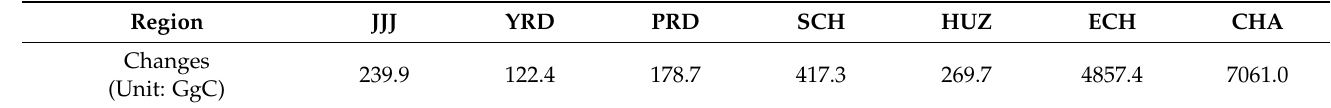
Table 5. Impact of land-use changes on BVOC emissions in typical regions under the carbon